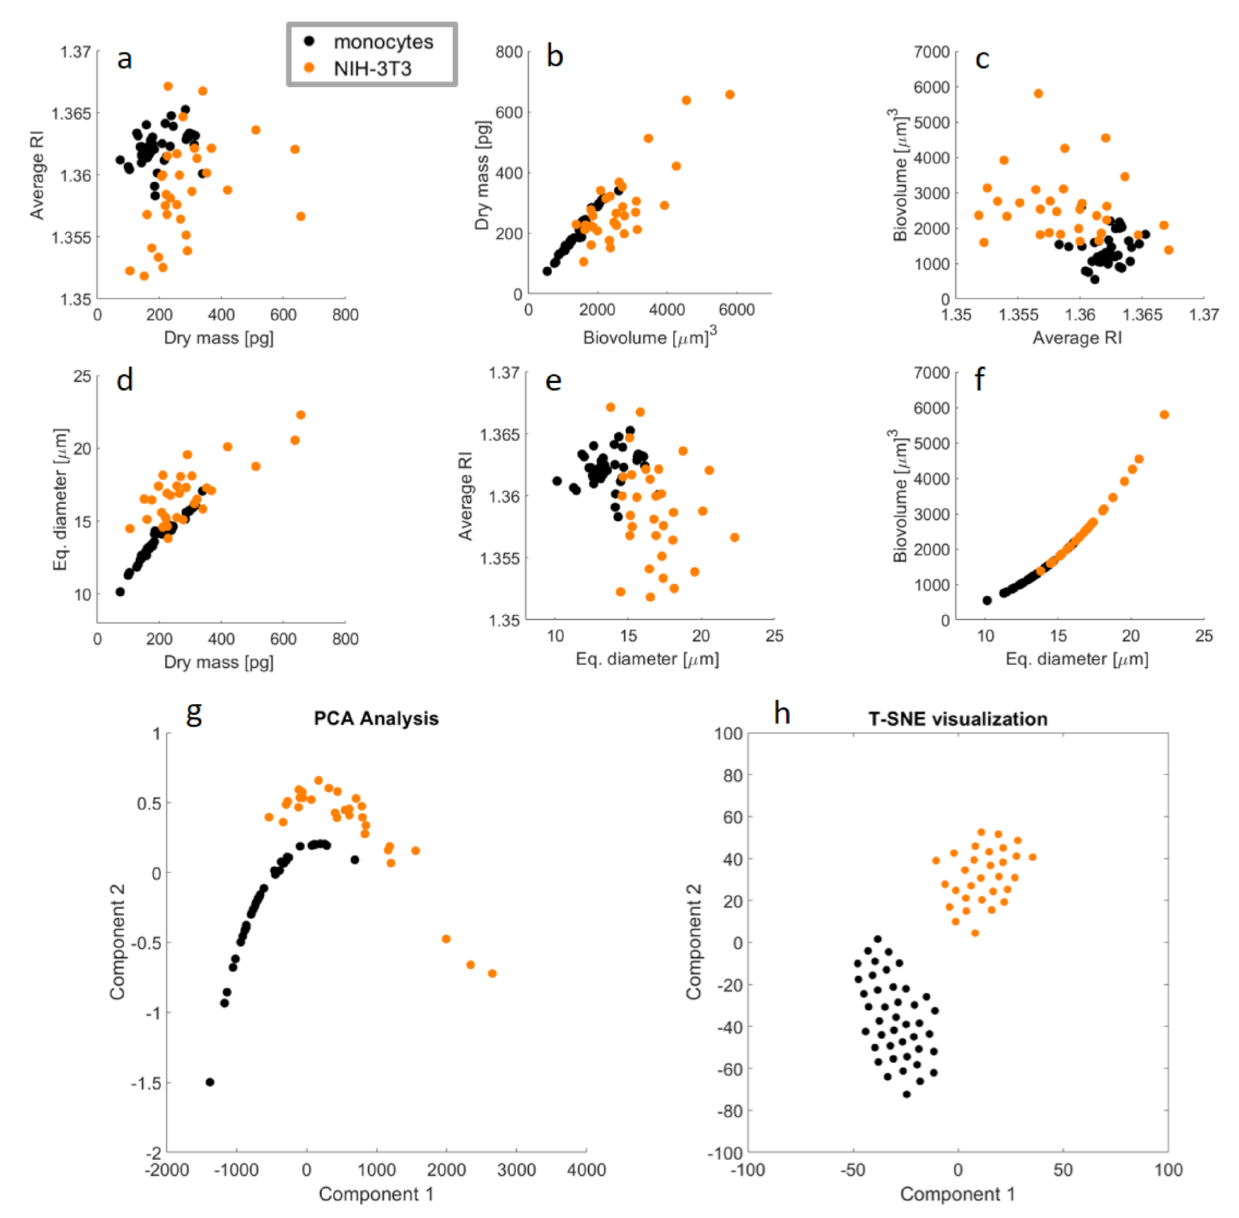
Figure 7. Data analysis comparing monocytes and NIH-3T3 cell lines; ( a – f ) display the scatterplots between each pair of the conventional morphology features calculated for the analyzed cell lines, i.e., average RI, dry mass, biovolume, and equivalent diameter. In particular, the subfigure ( f ) shows a quasi-linear trend, due to the obvious correlation between biovolume and equivalent diameter. This renders redundant the information content provided by the pair of subfigures ( b ) and ( d ) as well as ( c ) and ( e ), which display similar population distributions. Reported in ( g , h ) are two of the most popular methods for inspecting high-dimensional data, i.e. PCA analysis and the T-SNE visualization, respectively; these have the effect of removing such redundancy and show the spatial separation of the two analyzed cell populations, thus demonstrating the possibility of clustering